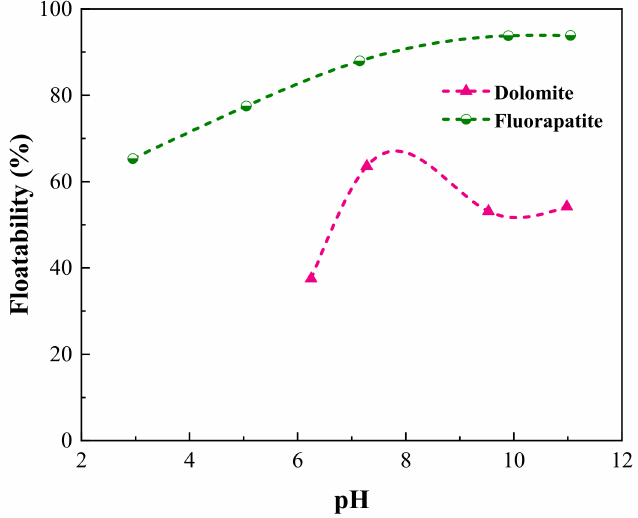
Figure 3. Effect of pH on the floatability of fluorapatite and dolomite (C SDBS = 50 mg · L − 1 , temperature = 15 ◦ C ± b